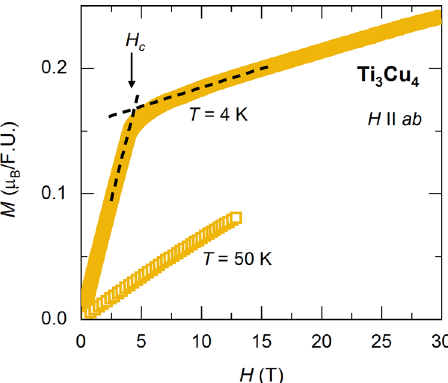
Fig. 4 Field dependence of the magnetization in Ti 3 Cu 4 . Field dependent magnetization M ( H ) isotherms in units of μ B per formula unit (F.U.) measured at temperatures T = 50 K (yellow, open squares), and T = 4 K (yellow, solid squares). Lines were fi t above and below the metamagnetic transition near 4 T (black, dashed lines). The intersection gives the critical fi eld H = 4.3 T at C